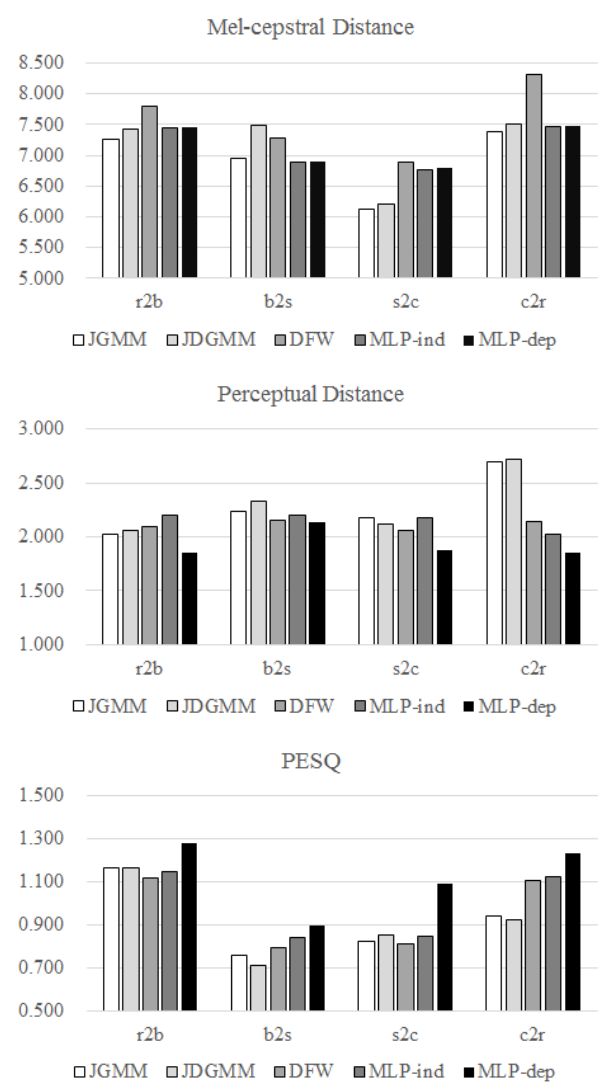
Figure 6. The objective evaluation results for each method, each conversion